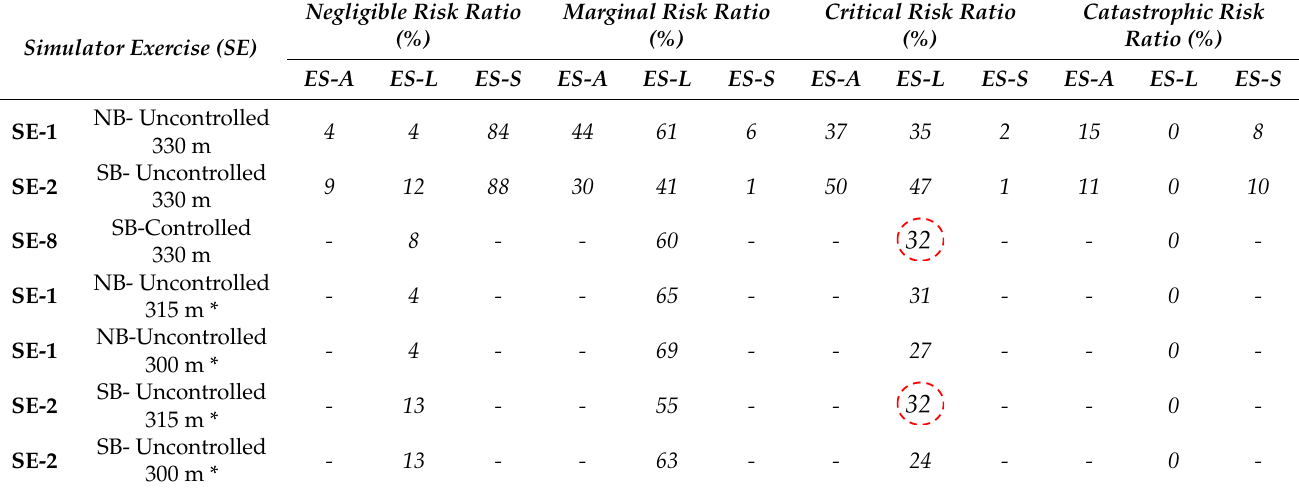
Table 3. General risk evaluation